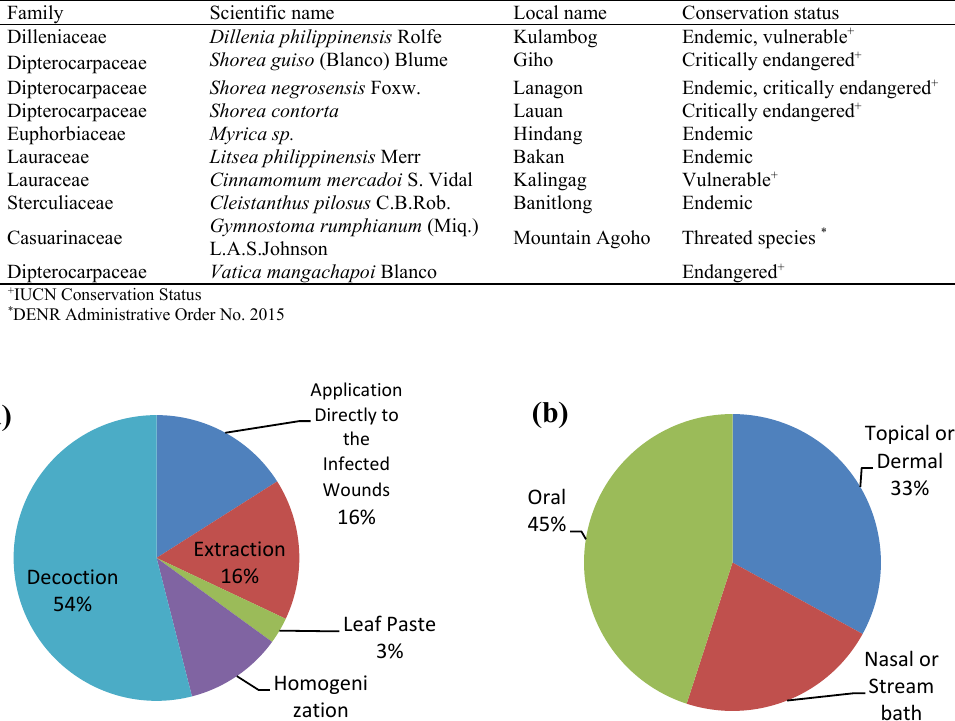
Table 2: Conservation status of some plant species in Lubilan, Naawan, Misamis Oriental